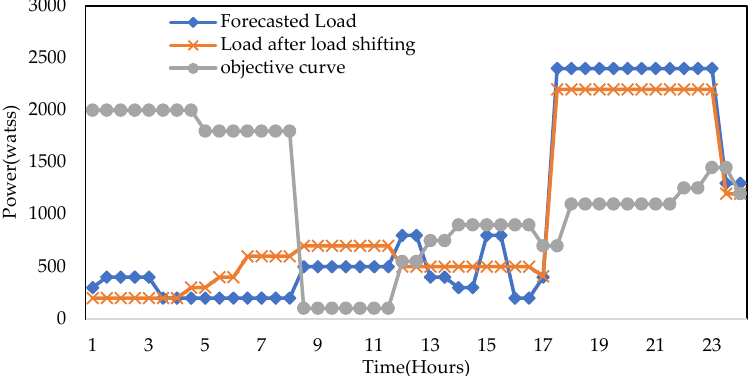
Figure 23. DSM results of residential load under winter conditions.